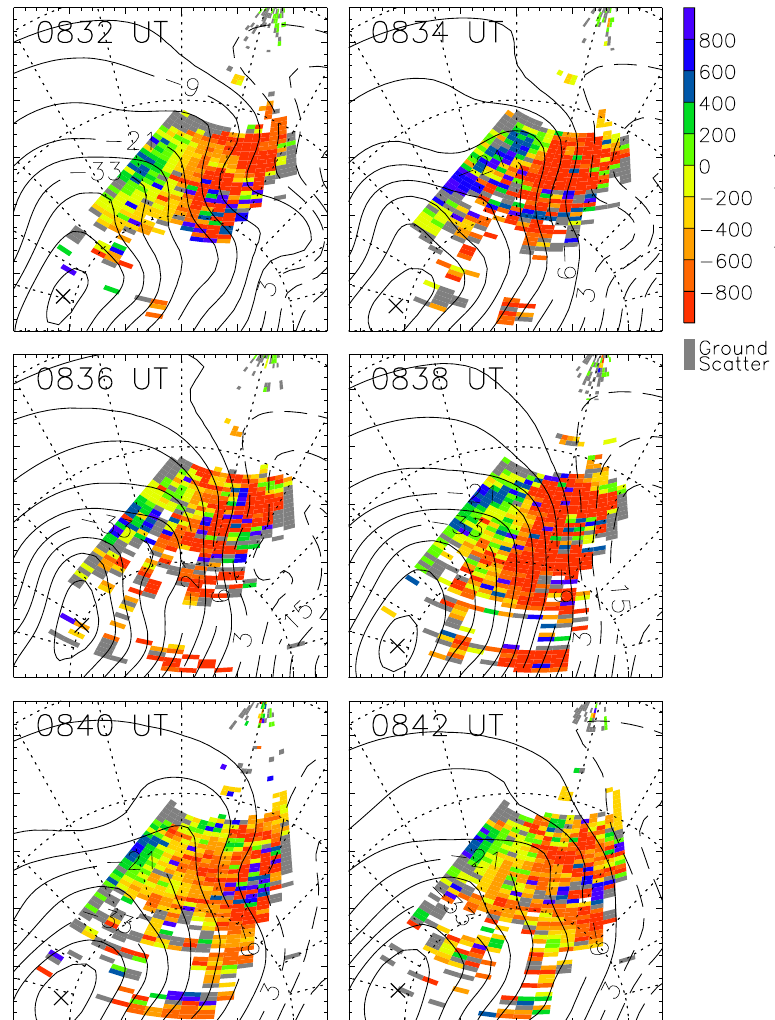
Fig. 8. Cutlass spatial plot of line of sight velocities from all 14 beams for the interval 08:32–08:42UT. Velocities are color-coded according to the scale to the right. Superimposed are plasma flow streamlines. The coordinate sys- tem is MLT/MLAT. 12MLT is at the top. Latitude circles at 60, 70, and 80 ◦ MLAT are